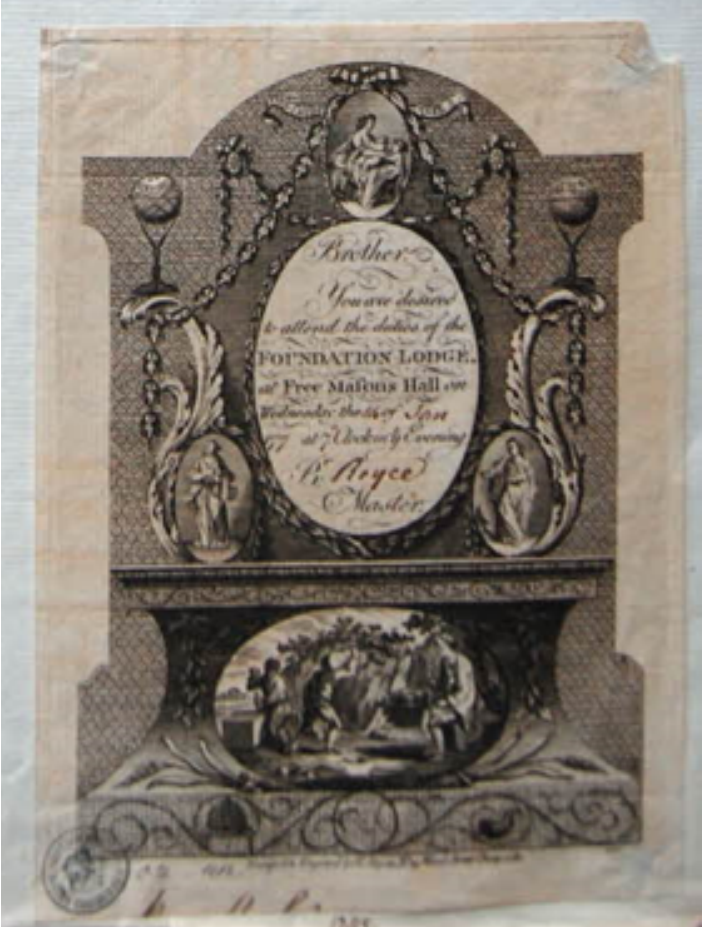
Fig. 24. Invitation to Free Masons Hall engraved by John Royce, Master in the 1770s. Copyright, The Trustees of the British Museum. C,2.1012